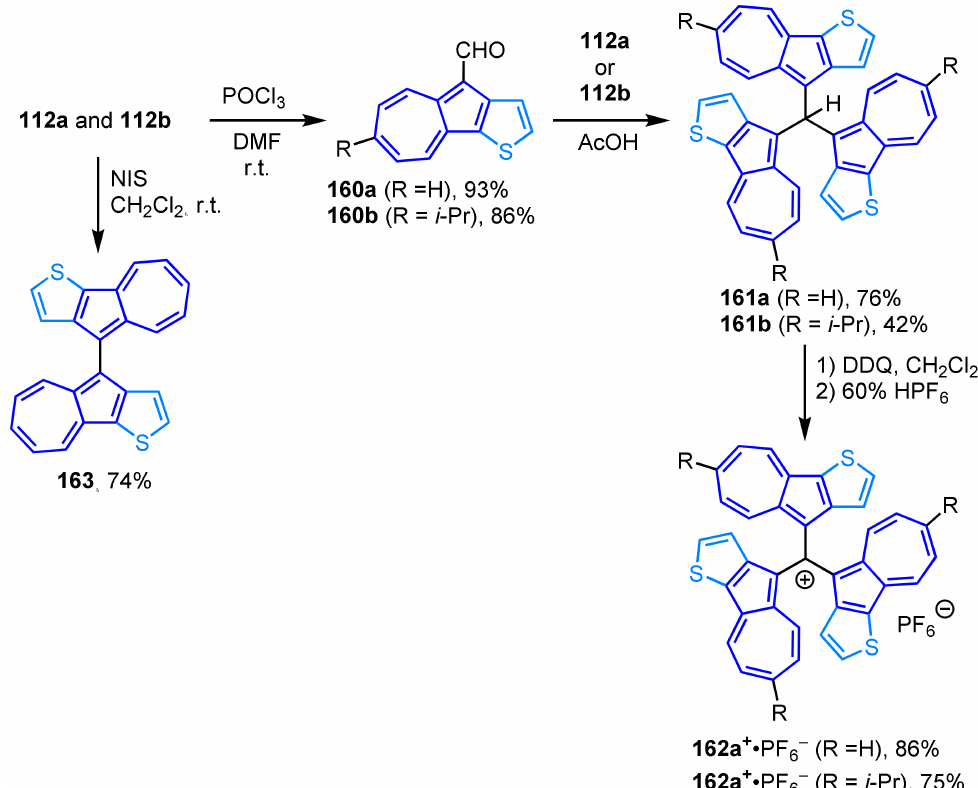
Scheme 39. Synthesis of tri(1-azulenyl)methylium ions 162a + and 162b + and 1,1’-biazulene derivative 163 by the reaction of azuleno[1,2- b ]thiophenes 112a and 112b